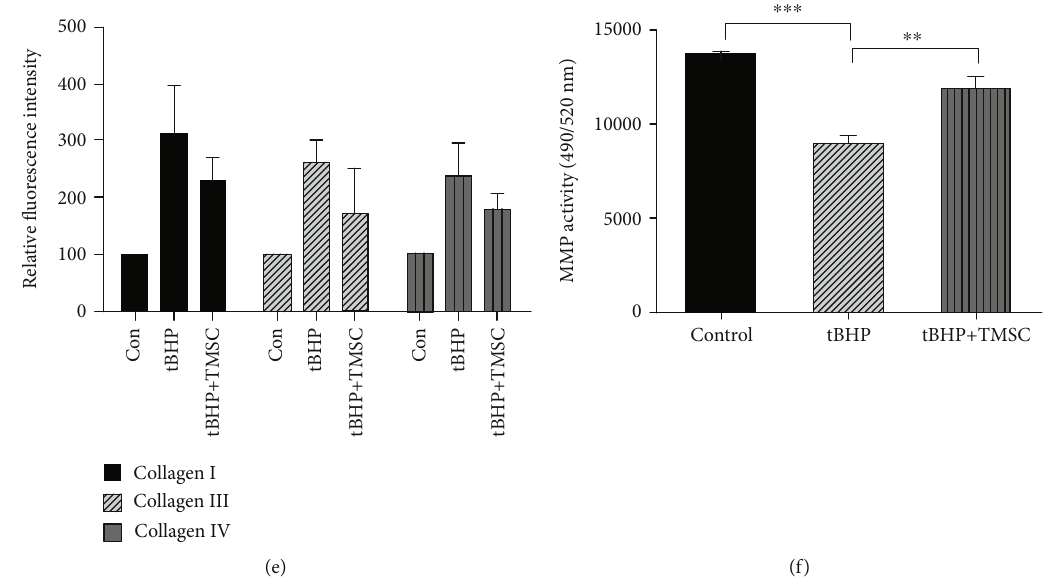
Figure 5: Dynamic changes in expression of extracellular matrix-(ECM-) related genes. (a – c) Relative mRNA expression of collagens I, III, and IV was determined to be signi fi cantly upregulated following tBHP treatment. Coculturing with TMSCs served to downregulate the expression of all collagen subtypes. (d, e) The representative immuno fl uorescence images for collagen staining (d). Images were quanti fi ed by measuring fl uorescence intensity (e). Similar to qRT-PCR results, oxidative stress enhanced collagen expression in hVFFs while TMSC counteracted tBHP ’ s impact. (f) MMP activity assay results showing that decreased MMP activity in tBHP-treated hVFFs was signi fi cantly restored after coculturing with TMSCs. Results are 3 technical replicates of TMSC from one donor. Representative results from two di ff erent TMSCs with similar tendency were presented. For multigroup comparison, ANOVA followed by the Bonferroni post hoc test was used for statistics. Results are shown as the mean ± SD . ∗ P < 0 : 05 , ∗∗ P < 0 : 01 , and ∗∗∗ P < 0 : 001